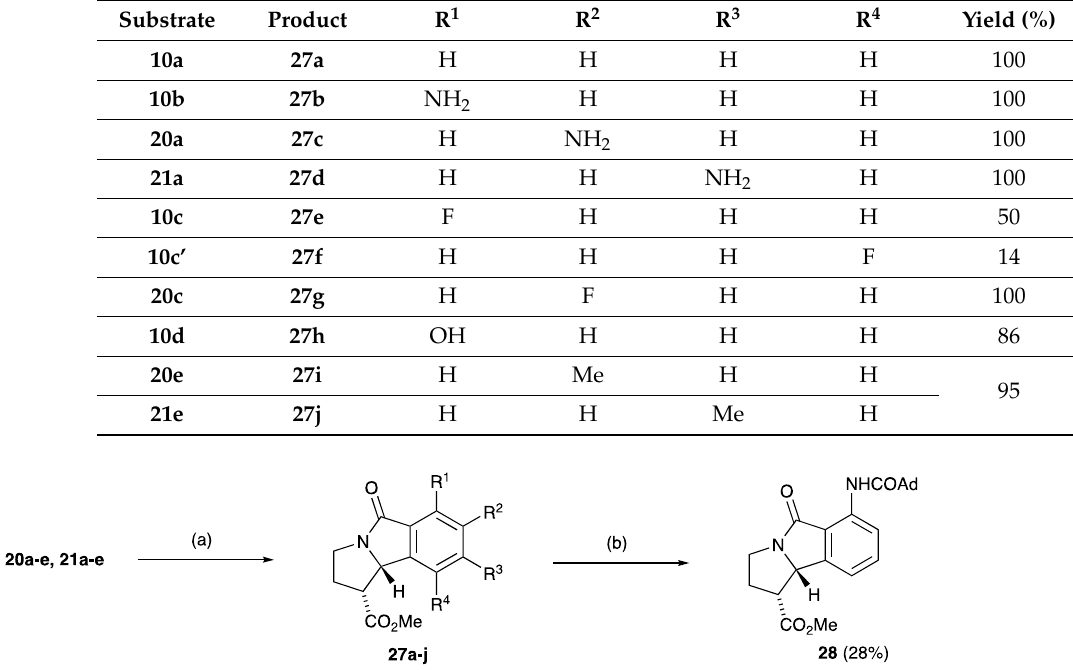
Table 2. Reduction of unsaturated bicyclic lactams 10a–d, 20a–e,